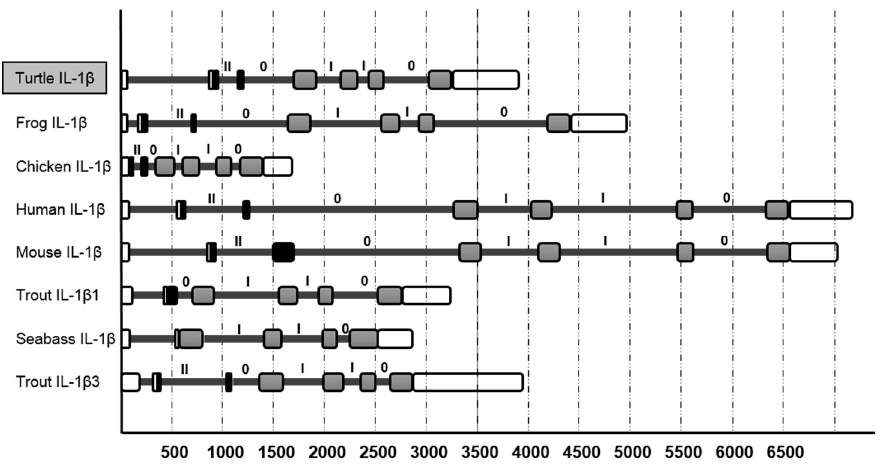
Figure 3. Comparison of the gene organizations and intron/exon sizes between P. sinensis IL-1 β and known IL-1 β genes. The coding regions are represented by filled boxes and the last four exons coding for the region of β -trefoil are filled in grey. The UTRs are depicted with an open box. Introns are shown as a black line with the intron phase above them. The accession numbers of the IL-1 β sequences are as follows: AJ314758 (African clawed frog IL-1 β ), ENSGALT00000000738 (chicken IL-1 β ), ENST00000263341 (human IL-1 β ), ENSMUST00000028881 (mouse IL-1 β ), AJ278242 (trout IL-1 β 1),